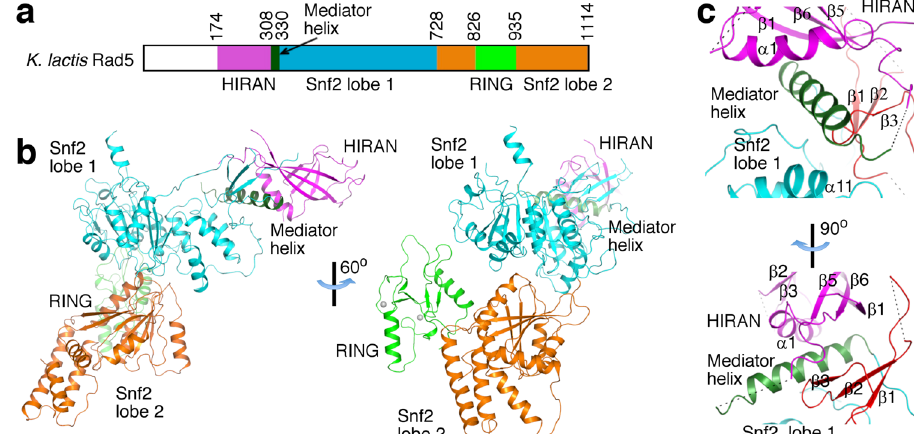
Fig. 1 Structure of Kl Rad5. a Domain organization of Rad5. The HIRAN and RING domains, the Snf2 domain lobes 1 and 2, and the mediator helix are indicated with different colors. The coloring scheme is used throughout the manuscript unless otherwise indicated. Domain boundaries for the K. latics Rad5 are indicated. b Crystal structure of Kl Rad5. Structural fi gures were prepared with PyMOL (http://pymol.org). c The mediator helix mediates interactions between the Snf2 and HIRAN domains. The β 1 – β 3 insertion in the Snf2 domain lobe 1 is highlighted in red. Dashed lines indicate disordered regions in our